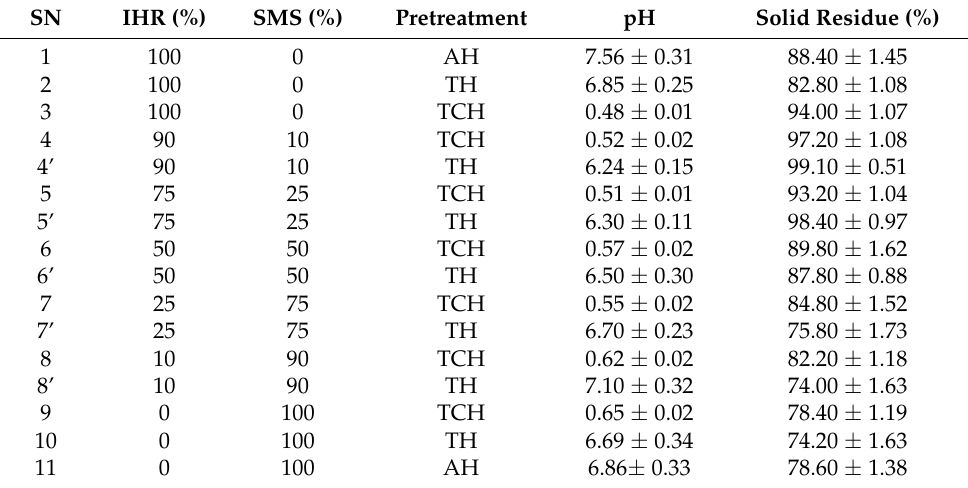
Table 1. Experimental setups and pH values of hydrolysates and the content of recovered solids after pretreatment of IHR and